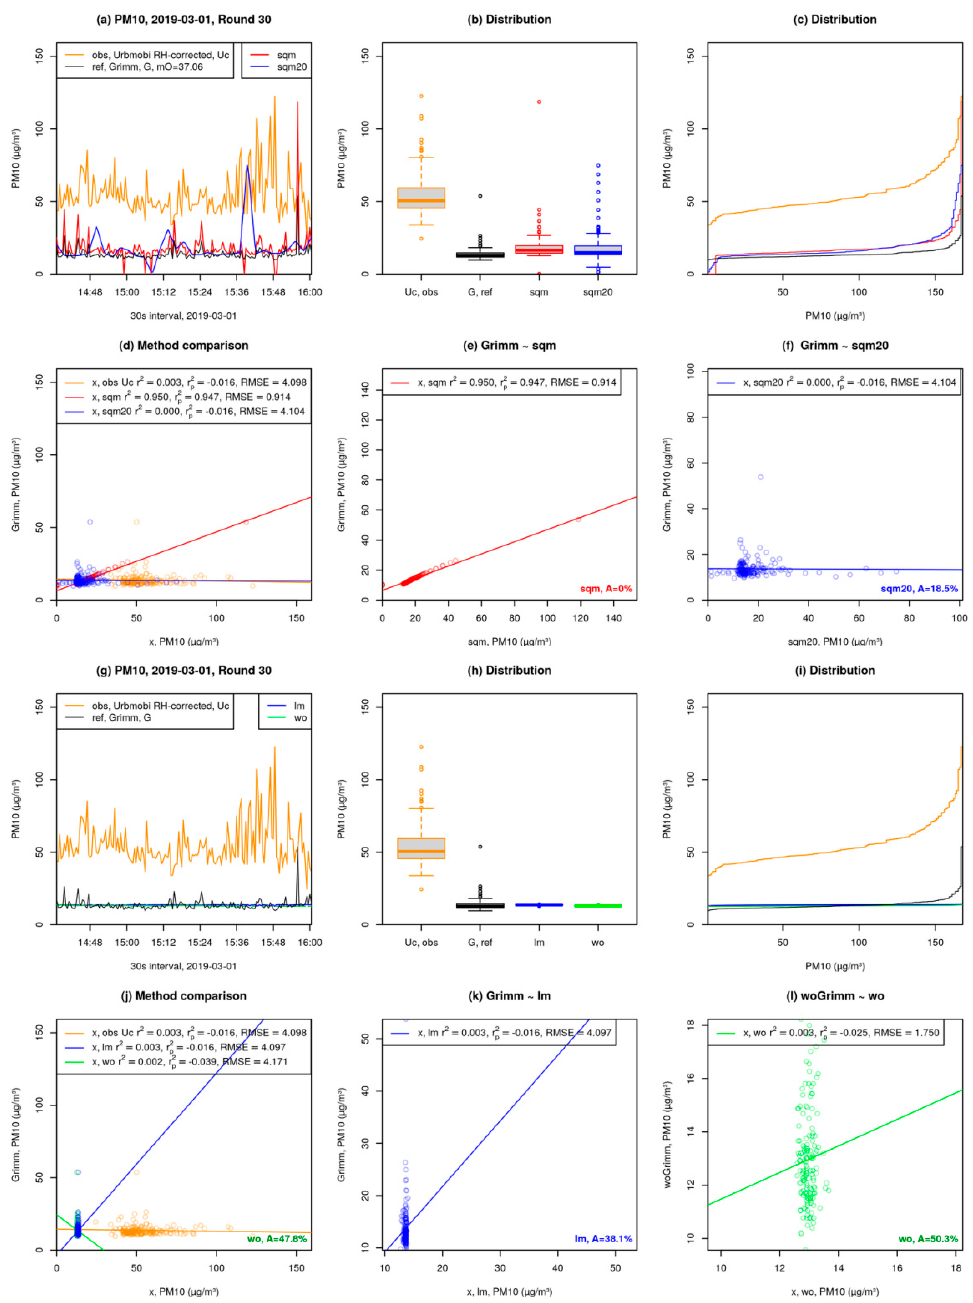
Figure 9. Factsheet for PM10 calibration of URBMOBI 3.0 with Grimm 1.109 as the reference; an example of a measurement round at Berlin-Hermsdorf with an accuracy of zero percent calculated after the calibration using the Quantile mapping method. Details for the subfigures are provided in the text under Section 3.3 and are the same as in Figure 7.